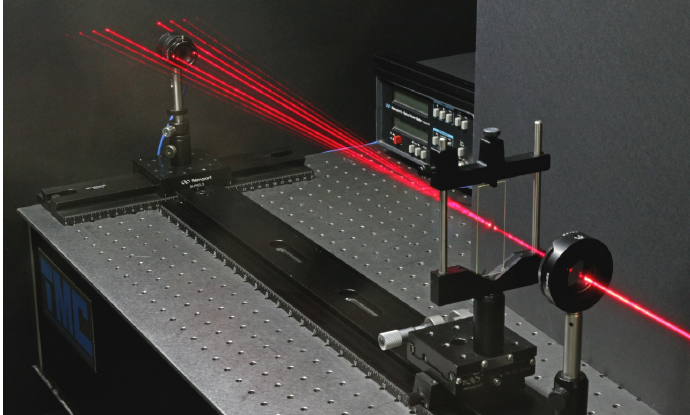
Figure 6. Long exposure photography of the experimental setup. On the right side, a polarizer, before one of the fabricated gratings, was placed to modify the intensity of the beam. On the left side, you can see the detector head, with a diaphragm on its front. The stabilized He-Ne laser used in the measurements is not shown in the picture.